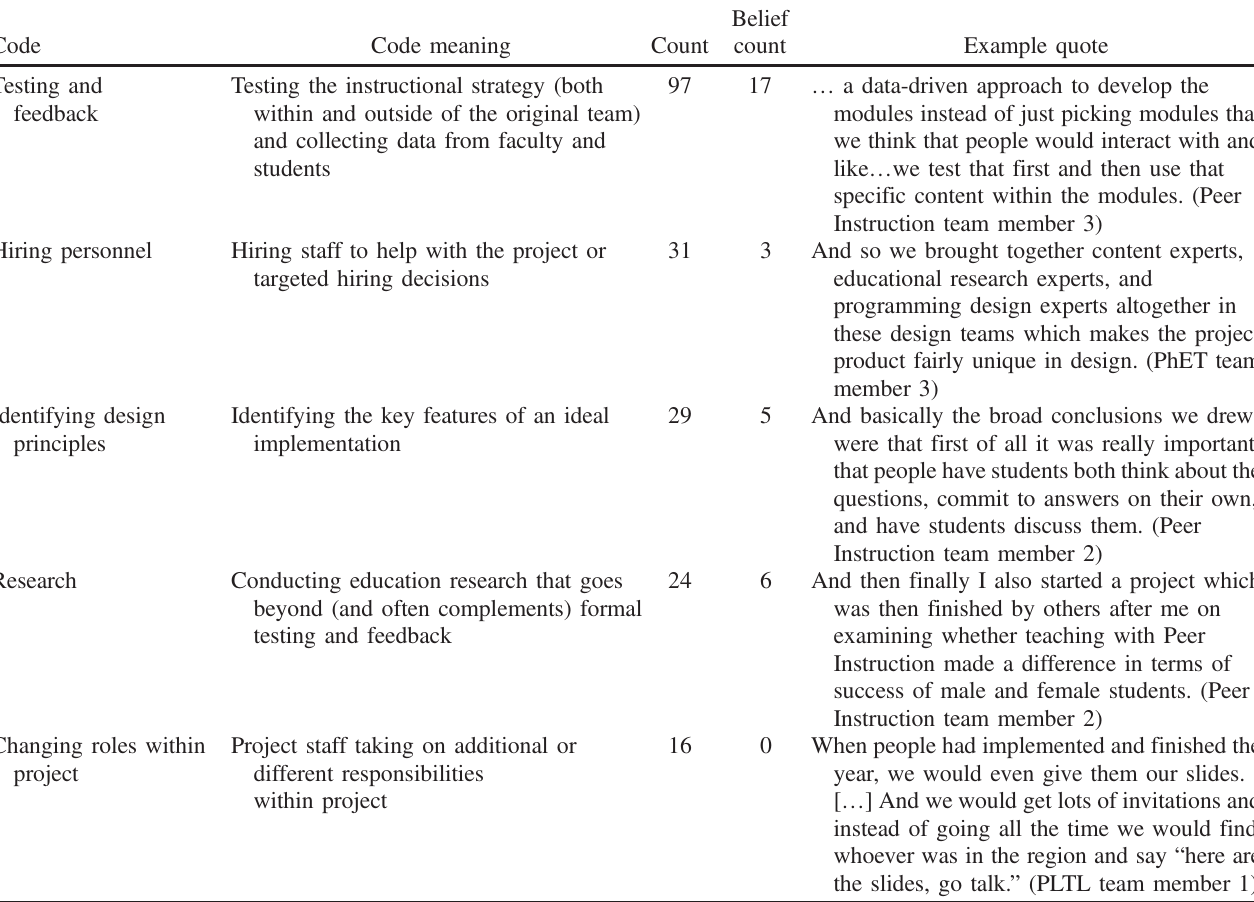
TABLE V. Codes and example quotes for the development category. The counts represent the number of times an action was coded and the number of times the subcode belief “ contribution to success ” associated with that action was